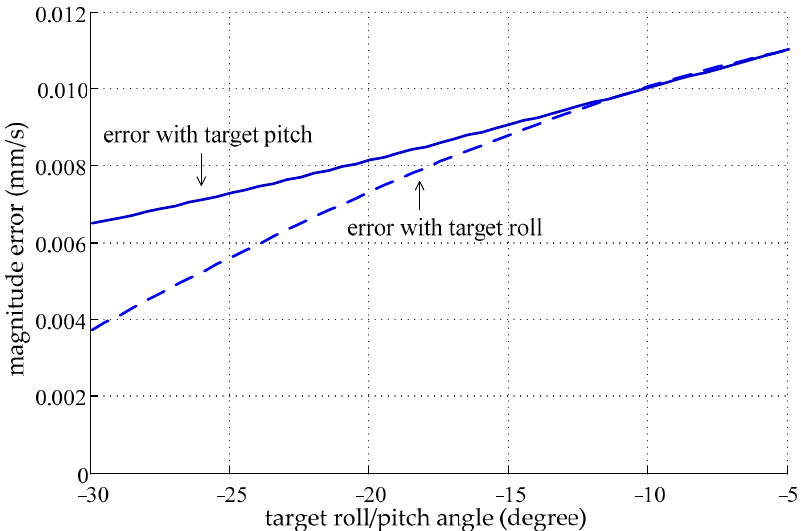
Figure 8. Maximum deviation of the IMLV with the target roll and pitch angles.